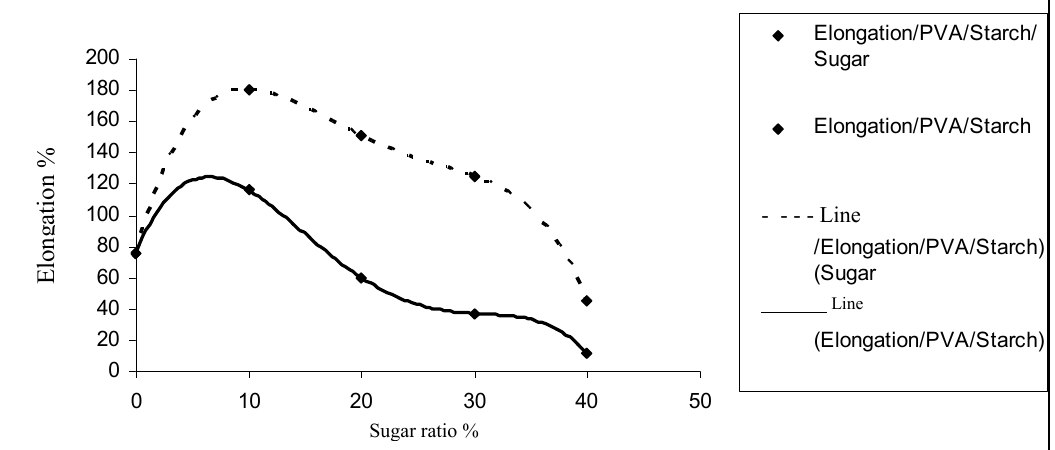
Fig. 8: The Elongation against the starch, and sugar